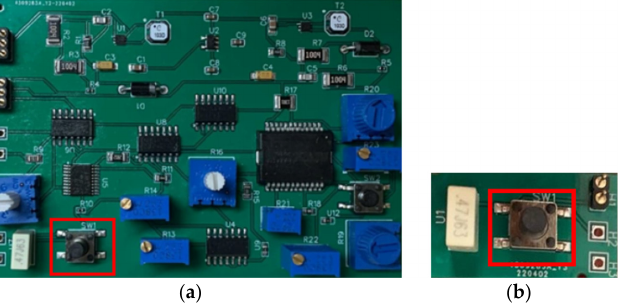
Figure 2. ( a ) FES circuit board with red box around the tactile switch; ( b ) small PCB board with red box around the tactile